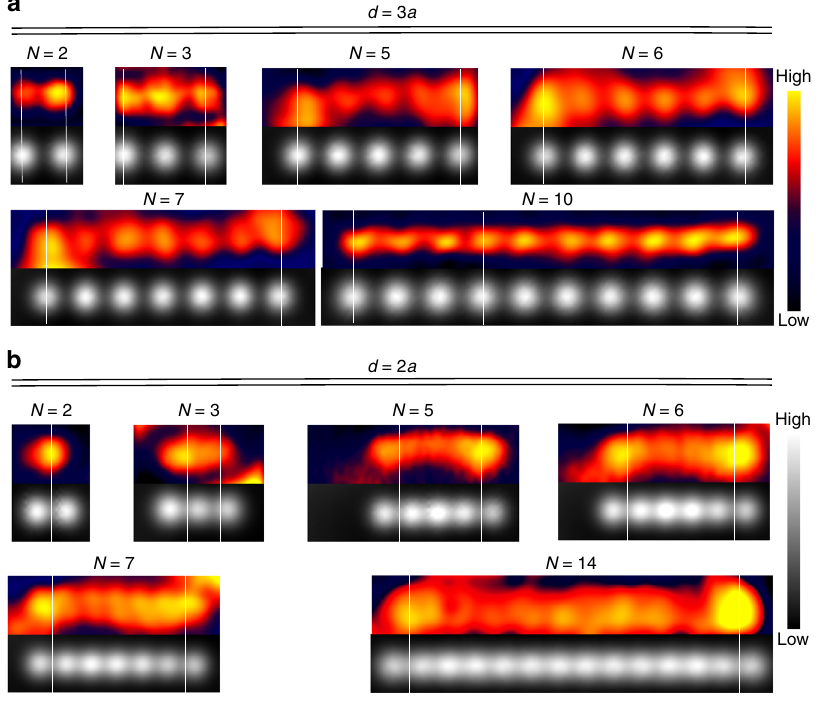
Fig. 4 Spin de-con fi nement in 1-D arti fi cial Kondo lattices. Simultaneous constant height tunnelling current (greyscale) and Kondo amplitude A K (red-yellow scale) maps of N Co atoms chains with spacing d = 3 a ( a ) and d = 2 a ( b ). White lines are guides to highlight the position of the A K maxima with respect to the atoms ’ position. a At d = 3 a , all atoms retain an associated Kondo resonance, with maximum A K at end atoms for N < 10. b At d = 2 a , the A K edge maxima are found in between the two end Co atoms of each side. The bottom scale bar represents 2 nm and applies to the entire fi gure. All tunnelling current images (greyscale) were acquired at V ref = 17 – 20 mV sample